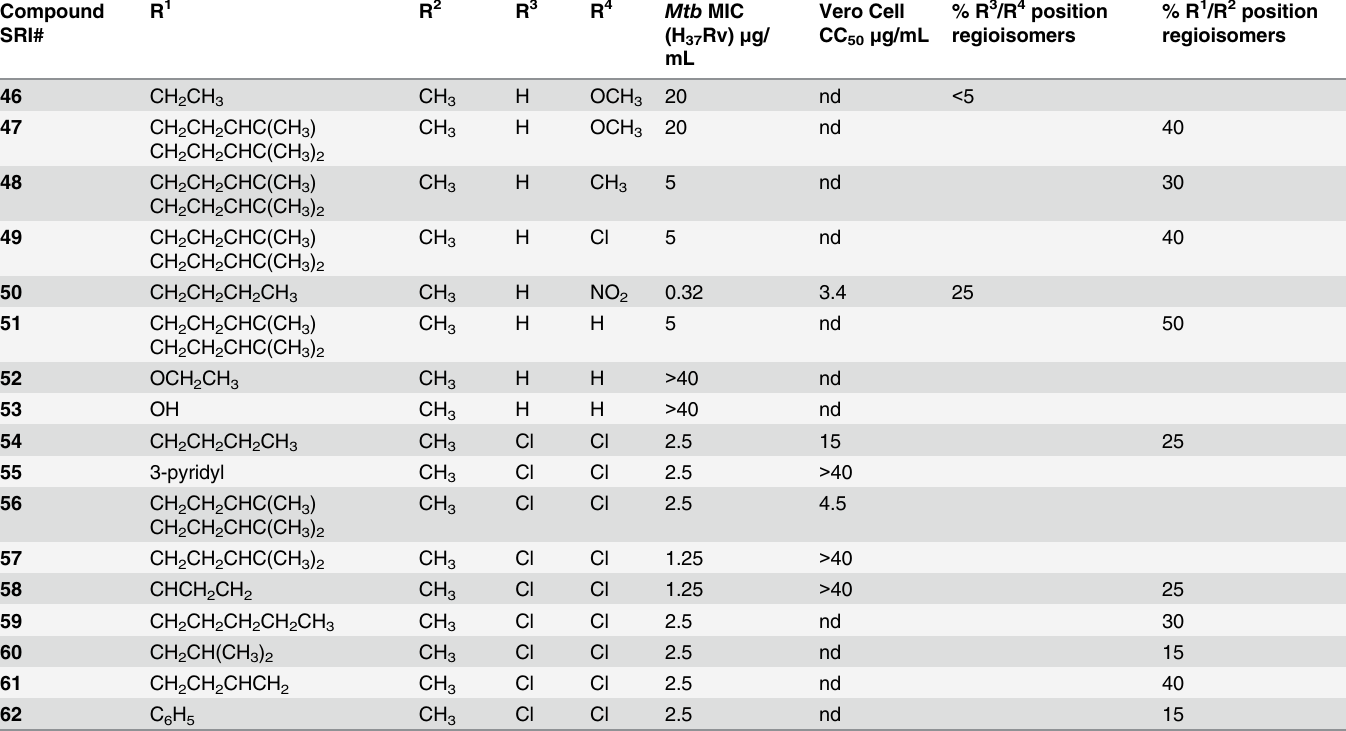
In vitro activity against MDR-TB To avoid pursuing hits modulating biological targets pertinent to known antitubercular drugs, we tested the most potent quinoxaline di- N -oxide SRI50 for activity against clinical MDR-TB strains with known drug resistance profiles [29]. SRI50 showed potent activity against clinical susceptible as well as clinical MDR-TB strains comparable to the laboratory H gesting a novel mechanism of action for this series (Table 4).